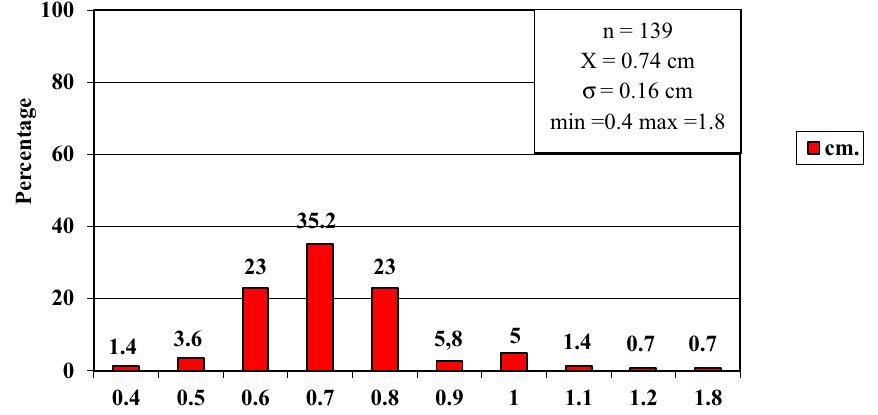
Figure 2. Diameter of the internal carotid artery. cm. centimetre, n sample size, X mean, σ standard deviation, min minimum value and max maximum value.